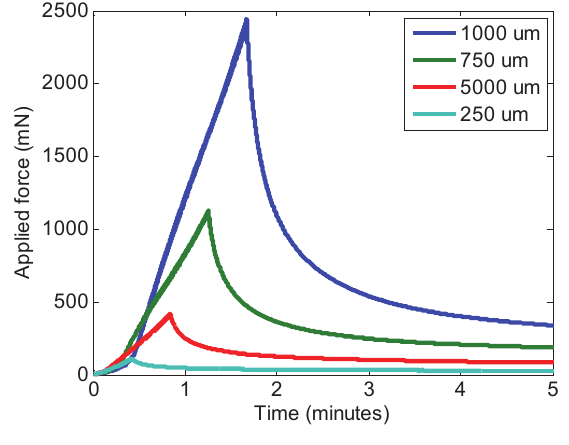
Fig. 17: Measured force during large strain indentation experiments into alginate hydrogel encapsulated fibroblasts. Legend denotes final indentation depth.